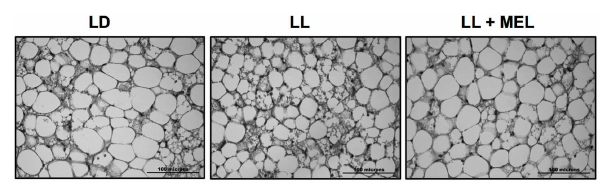
FIGURE 6 | Representative microphotographs of perirrenal adipose tissue from a 5days old LD lamb . LD, newborns gestated in ewes exposed to photoperiod 12:12; LL, newborns gestated in ewes kept in continuous light from 60% gestation to term and LL + Mel, newborns